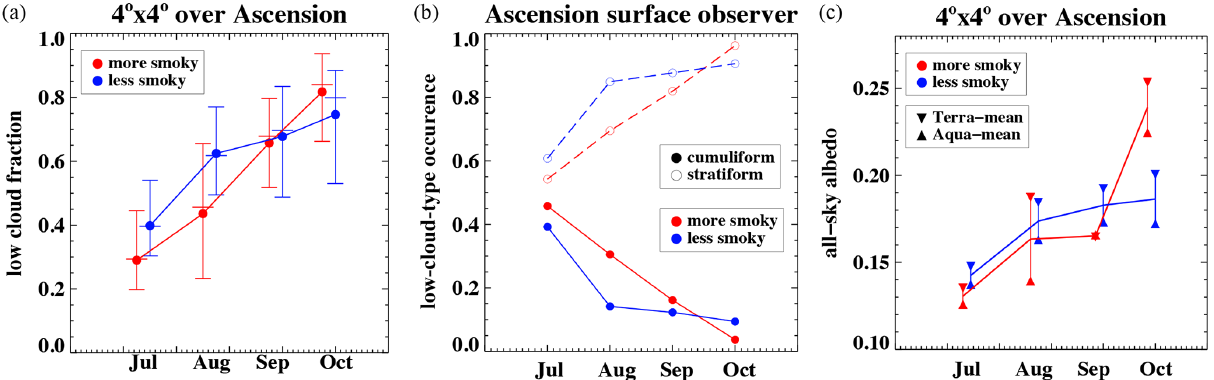
Figure 5. (a) SEVIRI-derived diurnally averaged areal mean (4 ◦ × 4 ◦ ) low-cloud fraction, with the diurnal range and median values also indicated, together with the (b) surface-observed cloud type frequency of occurrence (stratiform and cumuliform; empty and filled circles, respectively) and (c) all-sky areal mean CERES albedo for both Terra and Aqua. All are composited by high and low smoke (red and blue) loadings, as a function of the